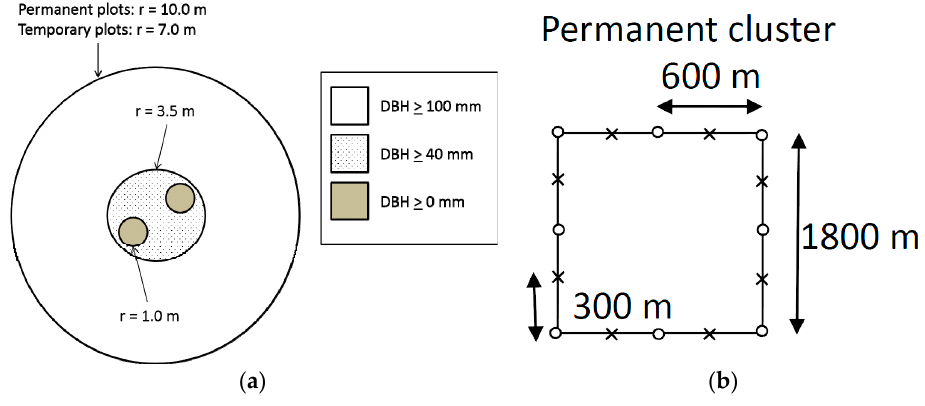
Figure 2. ( a ) Sample plot design used in the Swedish NFI since 2003. Note that trees with a diameter at breast height (DBH) of 100 mm or more are measured using different plot sizes on permanent and temporary plots. ( b ) Spatial arrangement of sample plots used in the Swedish NFI since 2003.